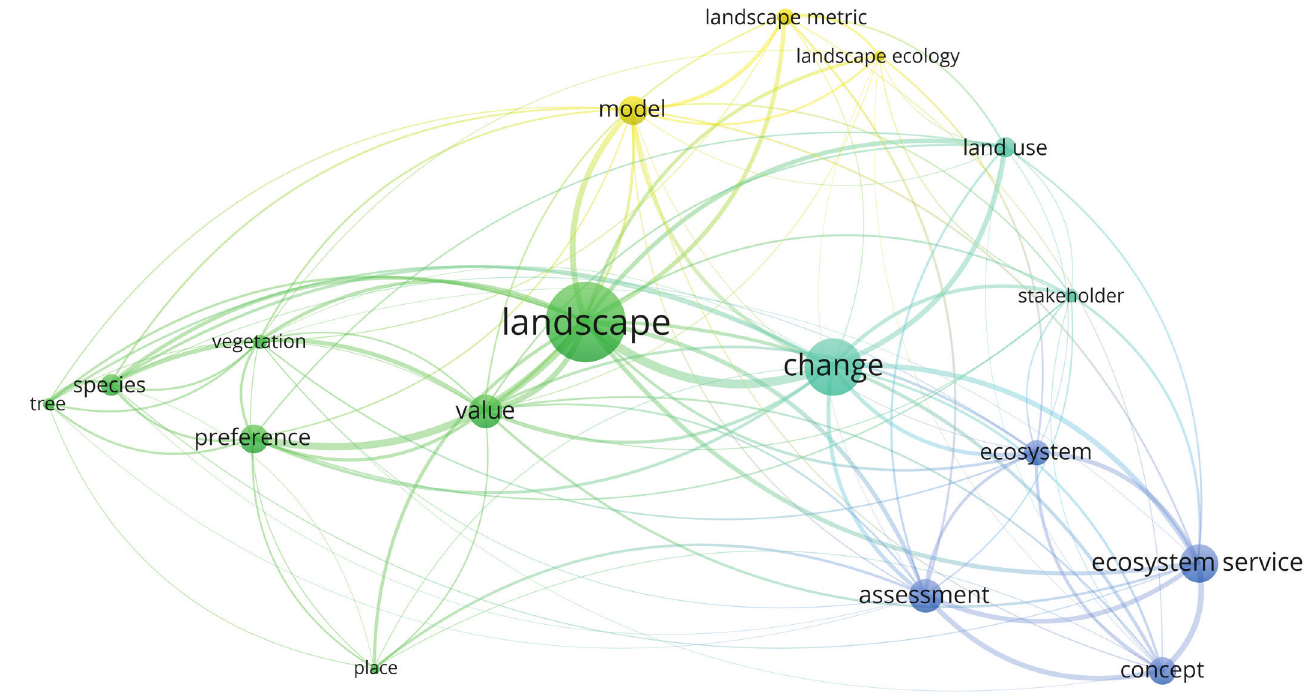
Figure 3. Topical relations of all articles published 2007-2022 based on title, abstract and